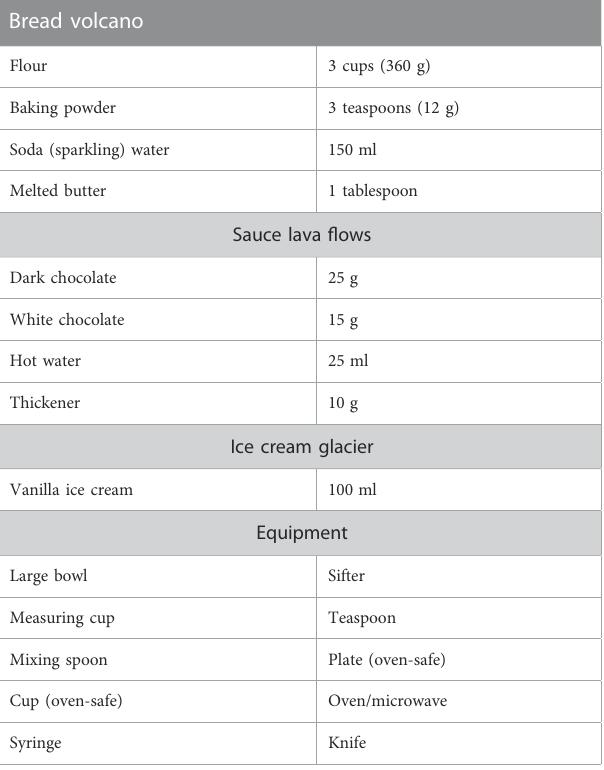
TABLE 1 List of ingredients and equipment required for the experiment. Bread